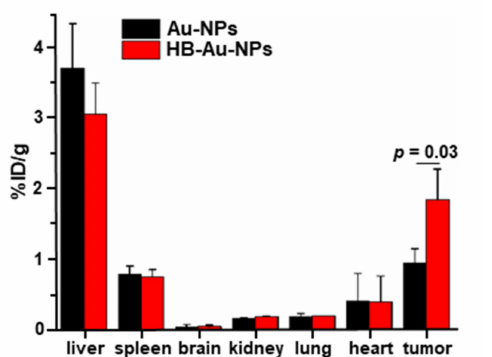
Figure 6. Nanoparticle biodistribution. In vivo uptake of HB-Au-NPs and Au-NPs by major organs, including liver, spleen, brain, kidney, lung, heart, and tumor is shown at 8 h post-injection in mice implanted with human xenograft tumor. The mean value in tumor was significantly higher for HB-Au-NPs than for unlabeled Au-NPs, 1.86 ± 0.43 versus 0.96 ± 0.20 %ID/g, in n = 3 animals, p = 0.03 by unpaired t-test.